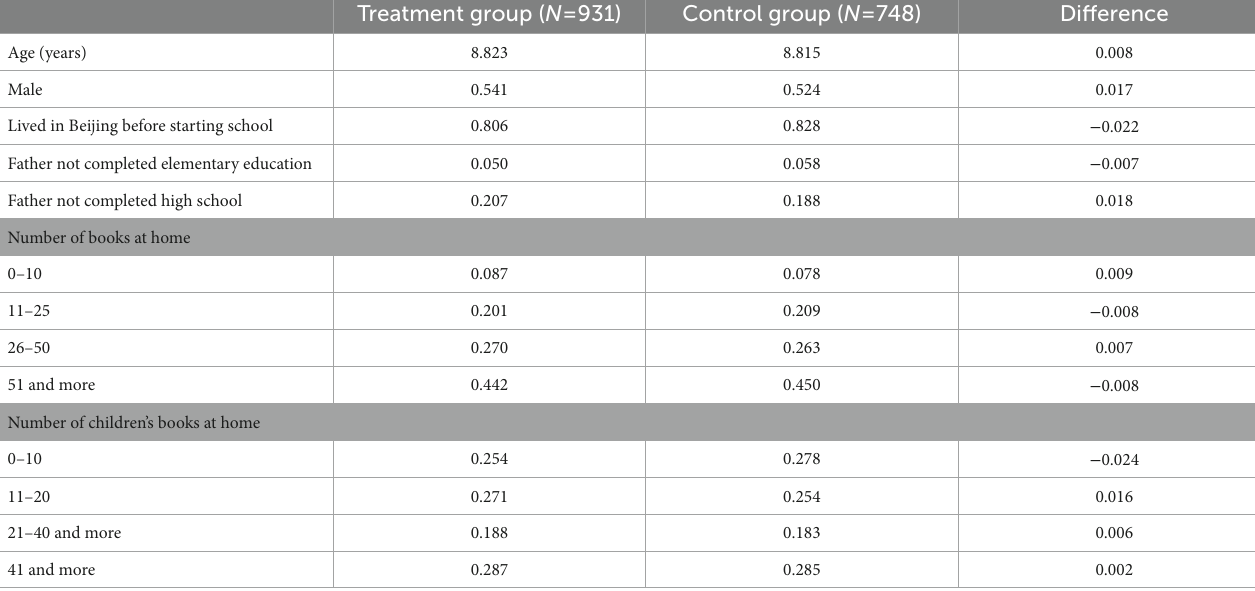
TABLE 1 Descriptive statistics for the treatment and the control